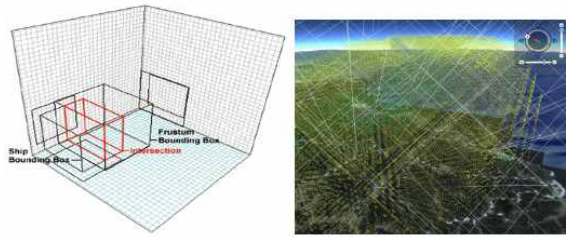
Figure 8. Applying the Loose Octree Algorithm (data source: MPSS, 2015-1)